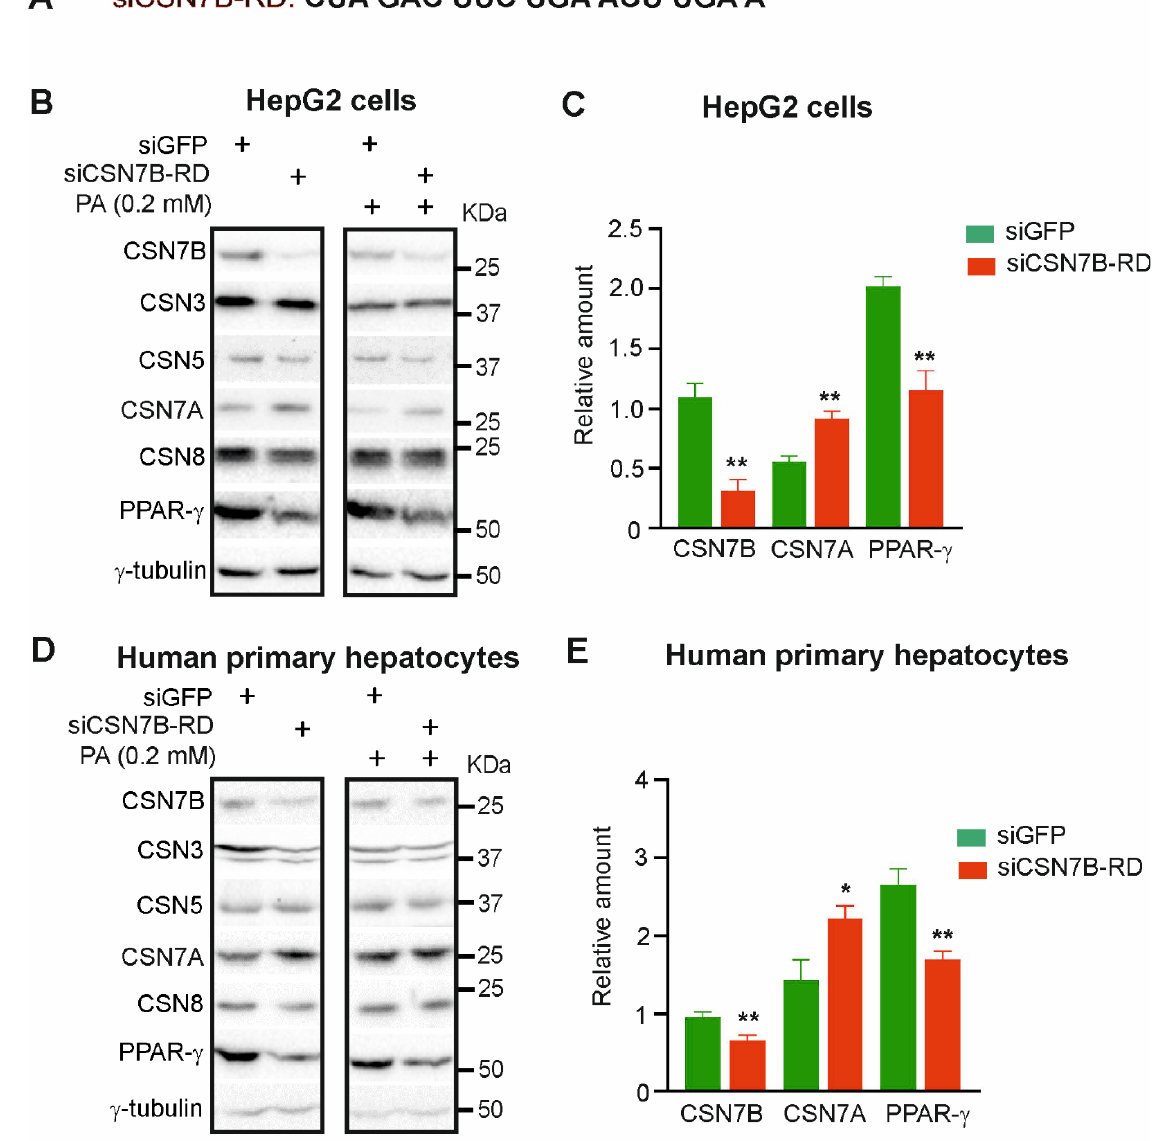
Figure 2. Silencing by siCSN7B-RD increases CSN7A expression and reduces PPAR- γ in HepG2 cells and in human primary hepatocytes. ( A ) The sequence of siCSN7B-RD. ( B ) Western blot of HepG2 cells transfected with siGFP or siCSN7B-RD for 24 h followed by treatment without (left panel) or with 0.2 mM of PA (right panel) for 24 h. Antibodies were used as indicated. ( C ) Blots as shown in ( B ) (left panel) were quantified by densitometry to measure the abundance of CSN7B, CSN7A and PPAR- γ after transfection with siGFP (control) or siCSN7B-RD. Data were normalized to γ -tubulin and expressed as means of relative amounts plus/minus standard deviations (SD, n = 3). Unpaired Student’s t -test was used for statistical analysis. ** p < 0.01. ( D ) Western blot of human primary hepatocytes transfected with siGFP or siCSN7B-RD for 24 h, followed by treatment without (left panel) or with 0.2 mM of PA (right panel) for 24 h. Antibodies were used as indicated. ( E ) Blots as shown in ( D ) (left panel) were quantified by densitometry to measure the abundance of CSN7B, CSN7A and PPAR- γ after transfection with siGFP (control) or siCSN7B-RD. Data were normalized to γ -tubulin and expressed as means of relative amounts plus/minus standard deviations (SD, n = 3). Unpaired Student’s t -test was used for statistical analysis. * p < 0.05, ** p <